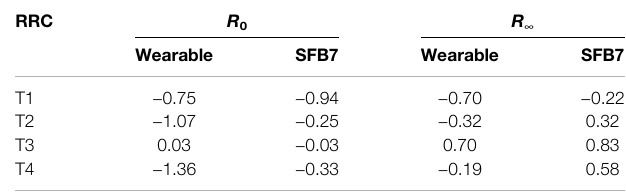
TABLE 2 | Minimum frequencies used for fi tting to the Cole model. All values shown in kHz. Fitting was not performed for textiles for subjects S4/S5 due to artifacts in the measurements (see Section 3.2 ).